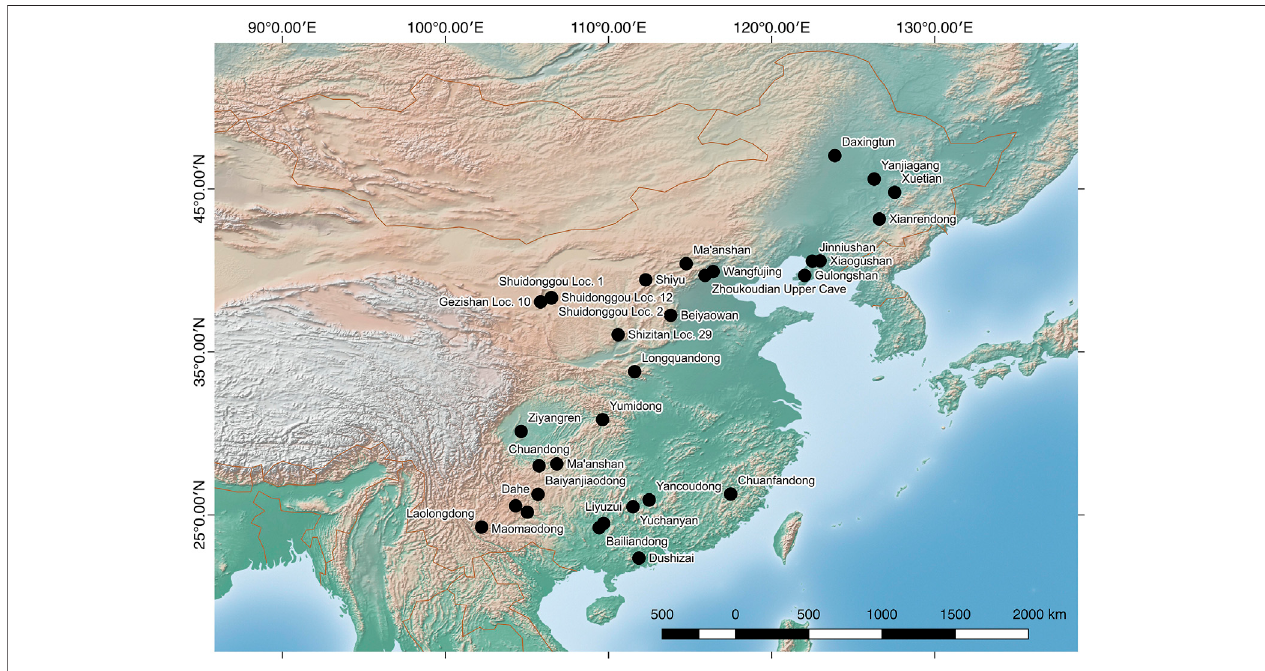
FIGURE3| DistributionofChineseUpperPaleolithicsiteswhereosseoustechnologywasreportedintheliterature(see Table1 fordetails).MapmadebyLDusing QGIS v. 2.14.3-Essen (Free Software Foundation, Inc., Boston) and free vector and raster from Natural Earth (naturalearthdata.com).